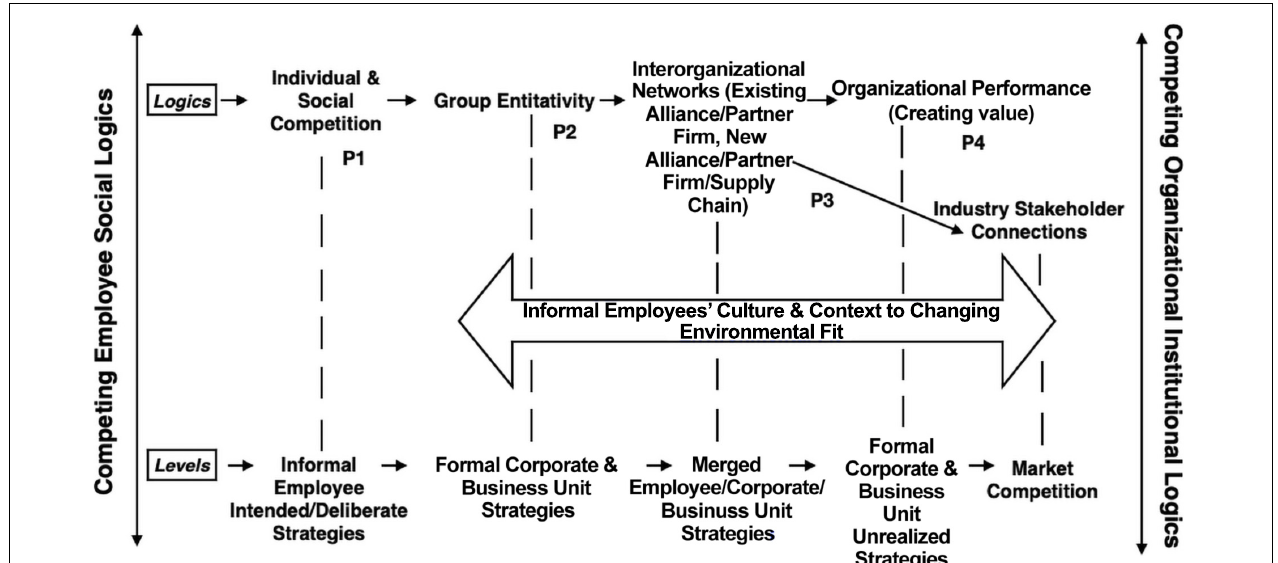
FIGURE 3 | Connecting informal employee social network strategies to formal firm